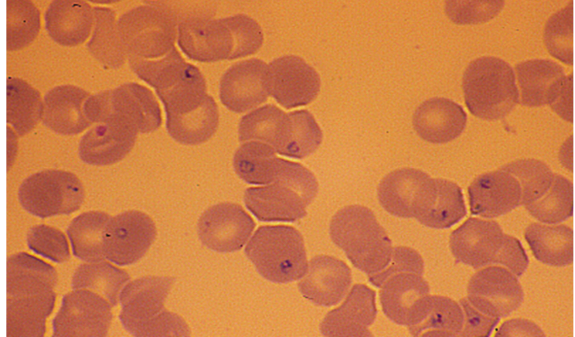
Figure 1: Ring forms of B. microti revealed by Giemsa staining of a human blood film (magnification 1000